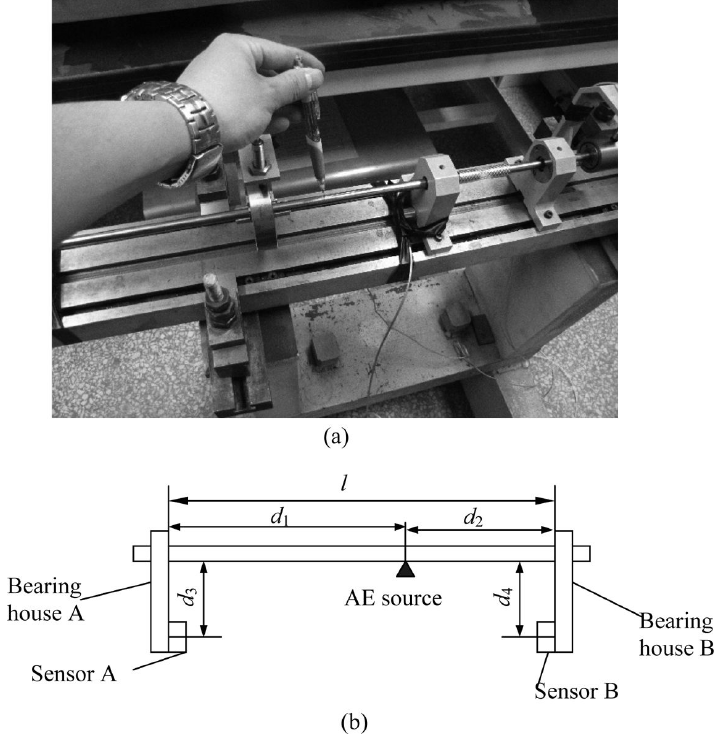
Fig. 3. Locating of AE